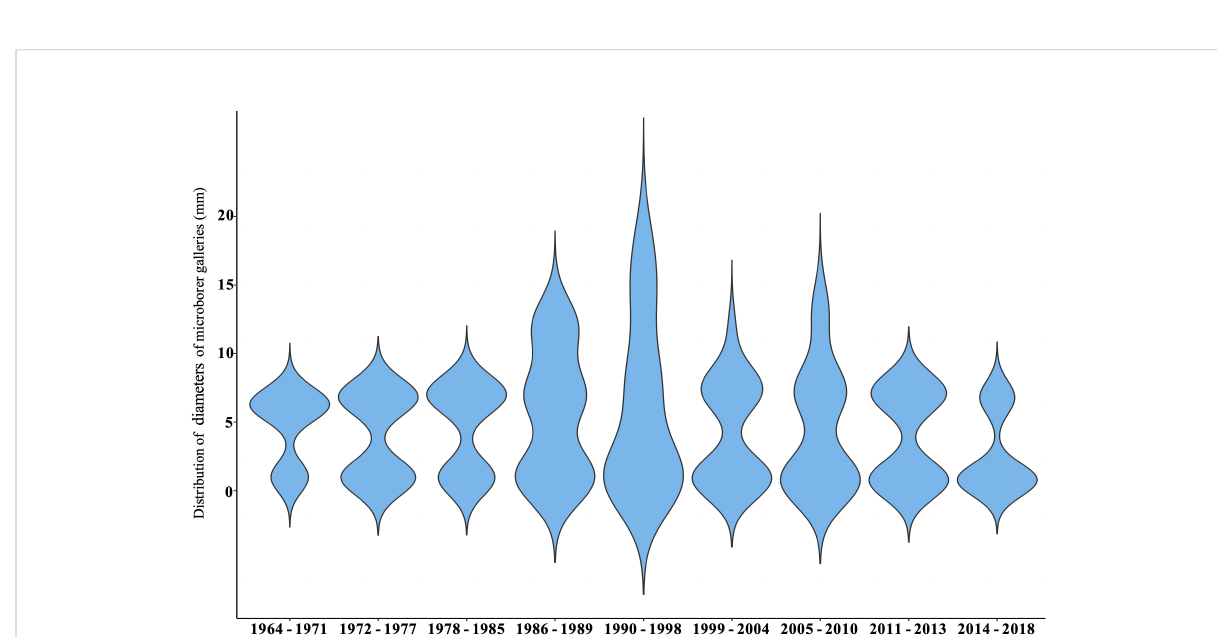
FIGURE 7 Violin plot showing the temporal variability in microborer traces ’ diversity identi fi ed based on their diameter.